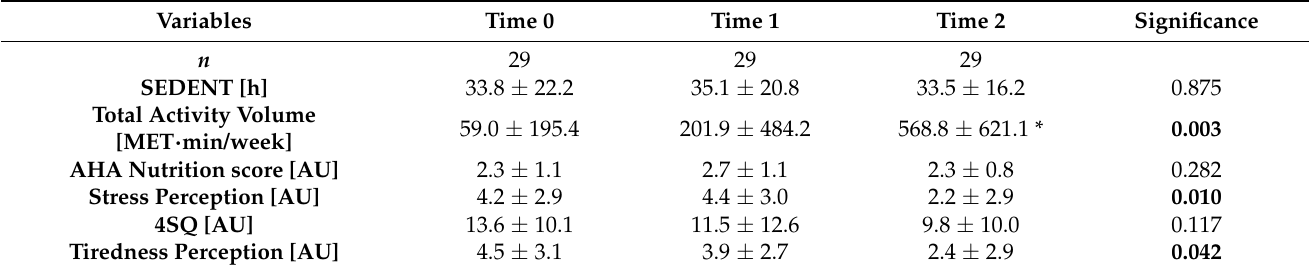
Table 2. Table descriptive of exercise, nutrition and stress perception variables at the three study epochs.